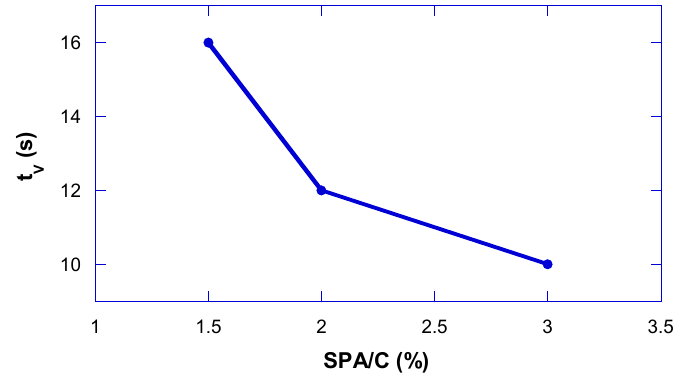
Figure 12. V-funnel tests results.